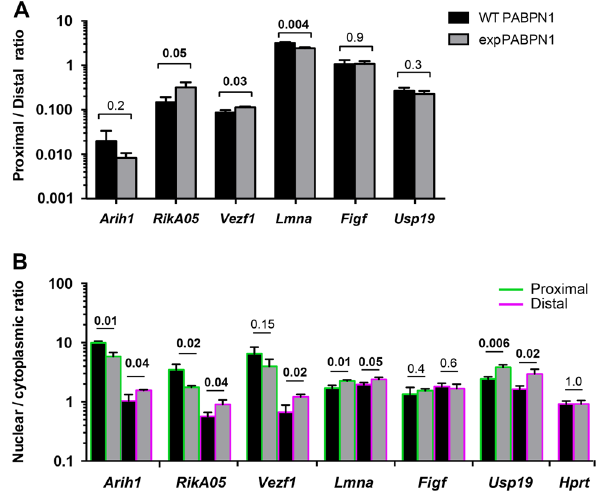
Fig. 6 The effect of expPABPN1 on PAS utilization in muscle cell culture. a Bar chart shows the ratio between distal and internal PAS from qRT-PCR analysis. Red outlines are depicted for a downstream switch, and blue outlines for an upstream switch and unchanged by a black line . b Bar chart shows changes in transcript abundance between nuclear and cytoplasmic fractions. Primer set amplifying intronic regions are depicted by green outlines and from primer set in the distal 3 ′ -UTR by purple outlines . Averages and SD are from three biological replicates. Differences between WT-PABPN1 and expPABPN1 cultures were assessed with the Student ’ s t -test. Signi fi cant p -values are in